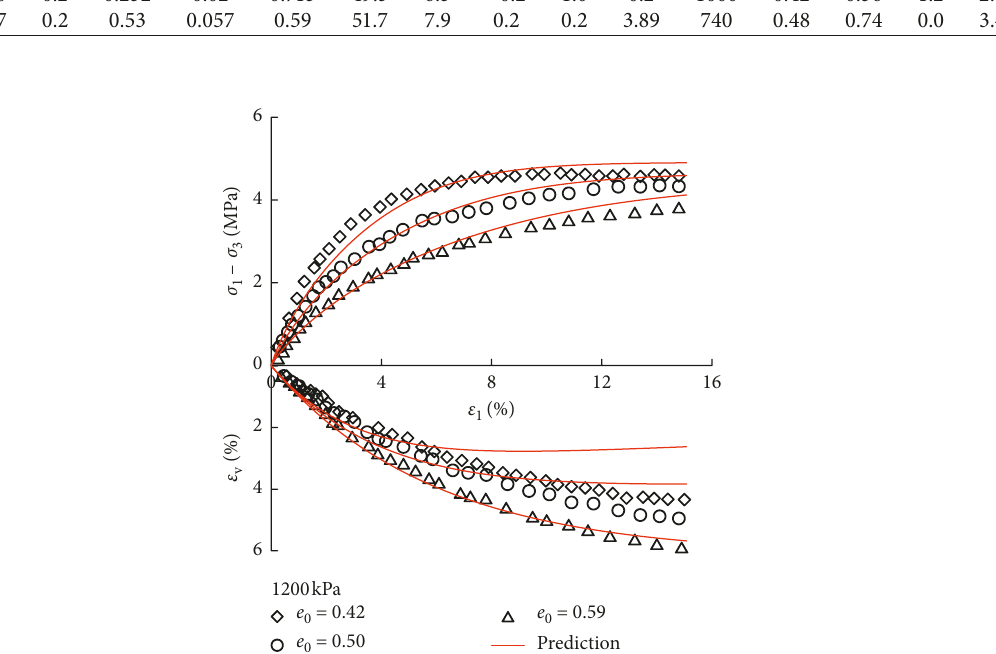
Figure 13: Experiment result and prediction of rockfill materials under 1200kPa confining pressure with different void ratios.